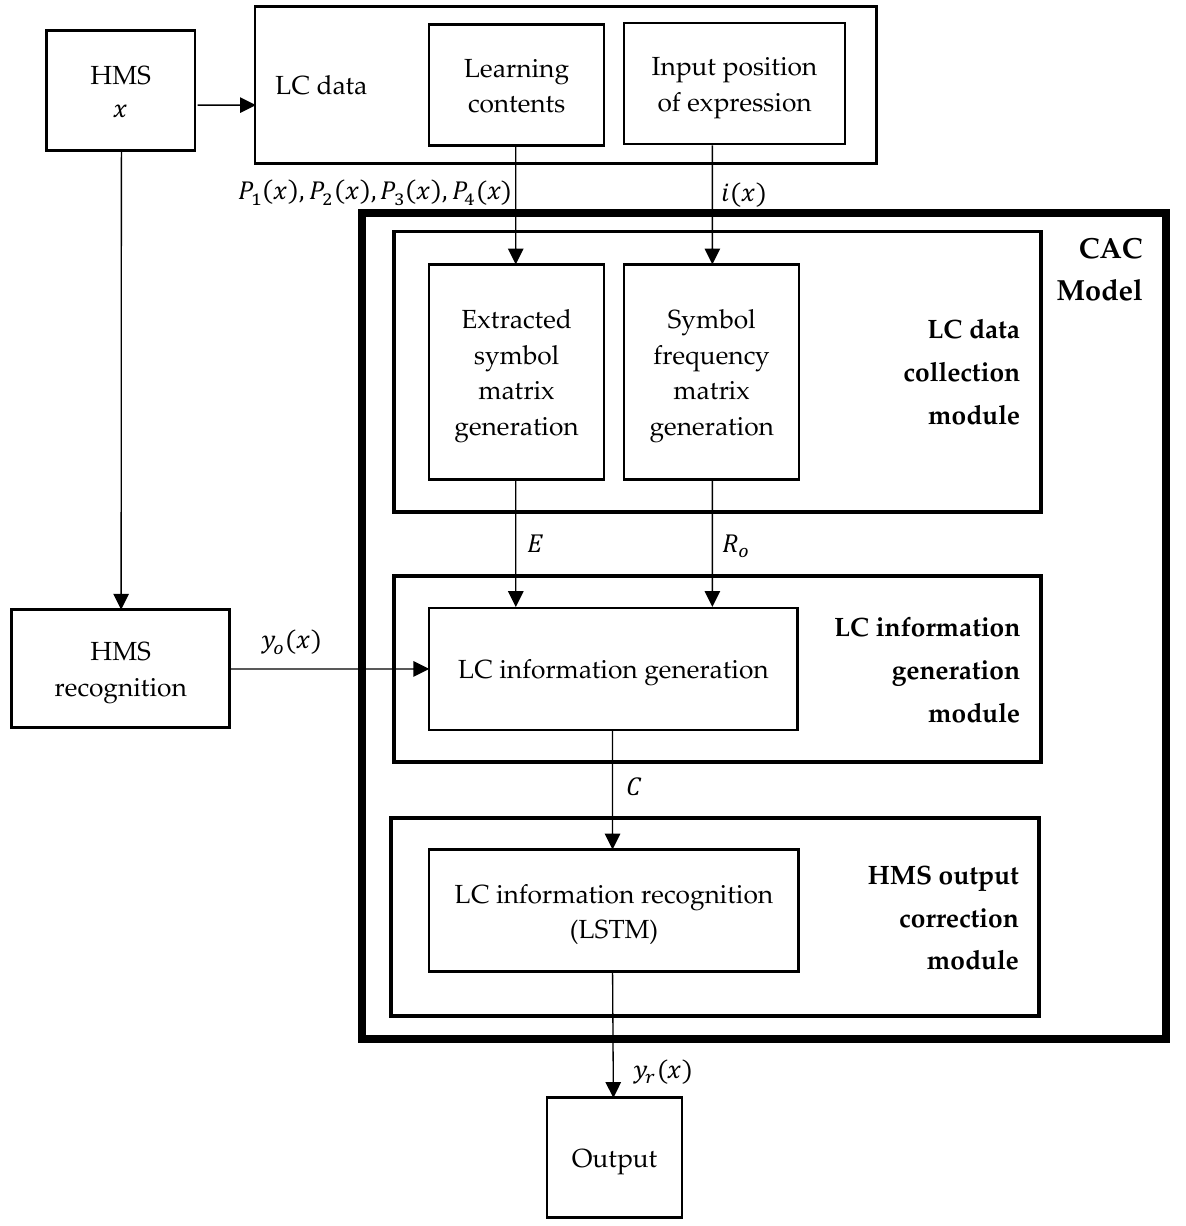
Figure 5. CAC model using LC information to recognize HMS.